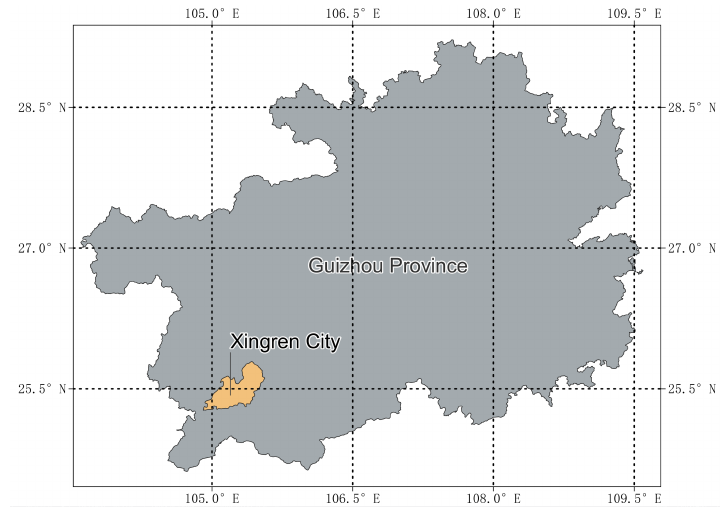
Figure 3. The study area in this paper. Table 1. Detail of the benchmark Barley